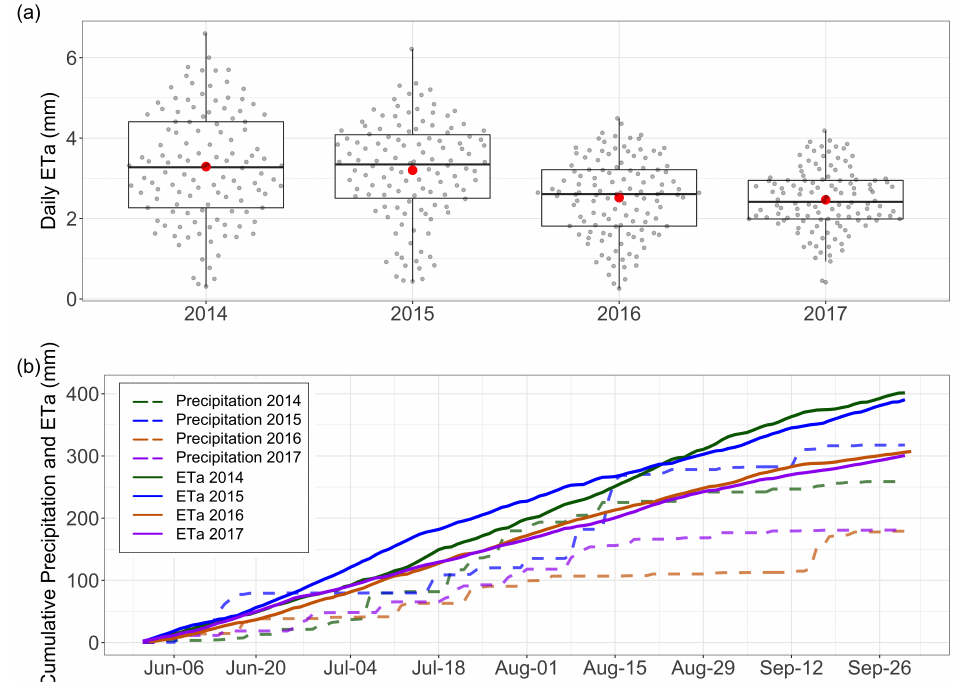
Figure 6. ( a ) Box plots of daily actual evapotranspiration for each growing season. Whiskers indicate the range within ± 1.5 IQR (Interquartile Range), and the horizontal line is the median value. The red dots are mean values. ( b ) Cumulative precipitation and actual evapotranspiration for the growing seasons in each